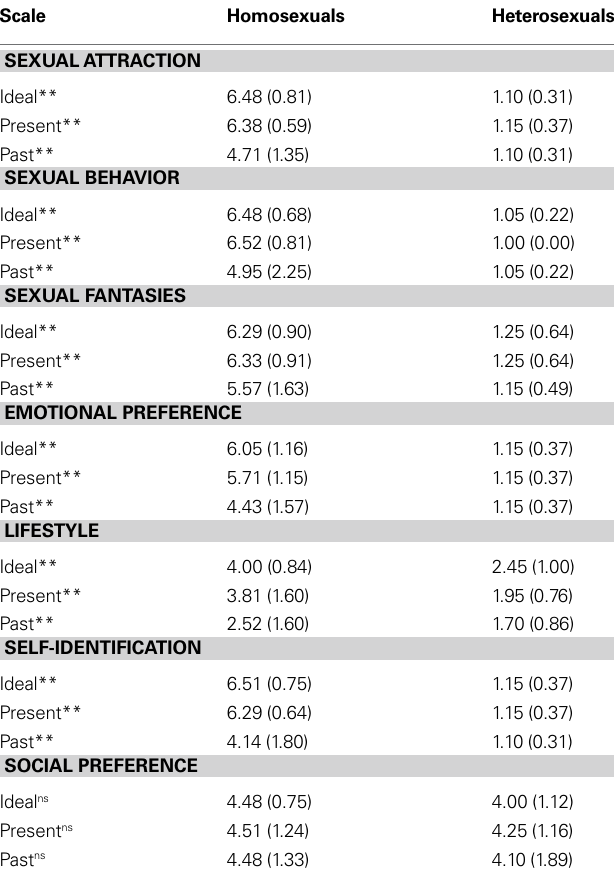
Table 2 | Mean scores of sexual orientation grid on 7-point